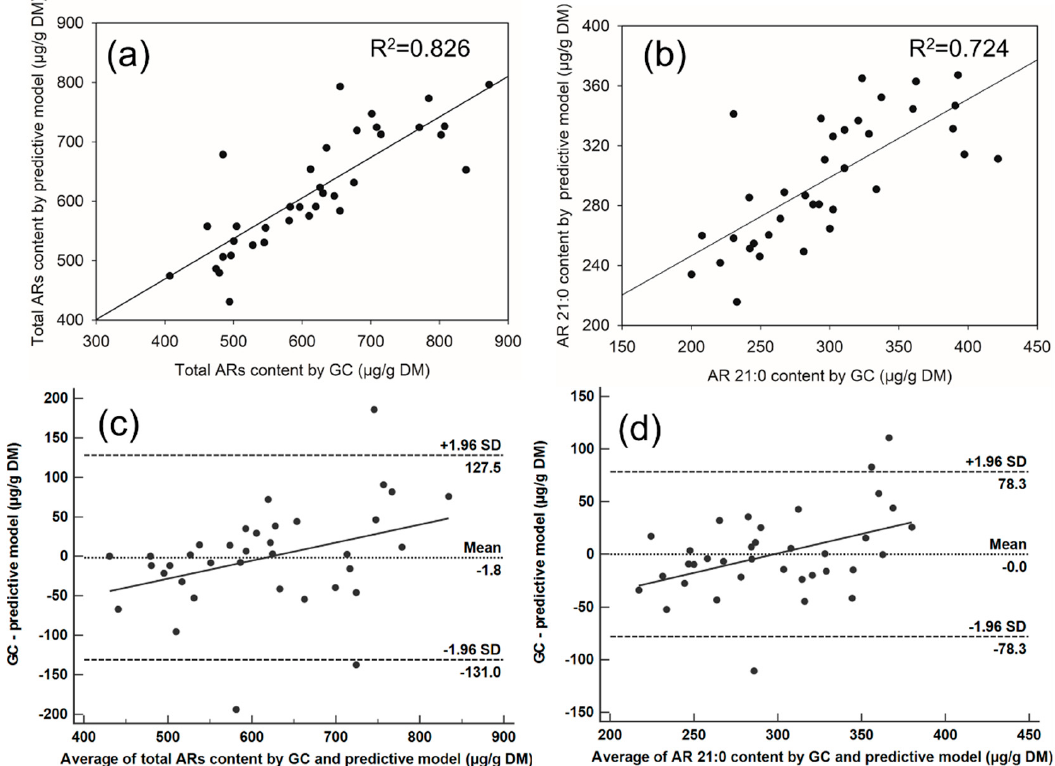
Figure 7. ( a ) AR 21:0 content in whole grain samples determined by GC and predictive model. y = 0.524x + 141.676 (n = 36, p < 0.001); ( b ) Total ARs content in whole grain samples determined by GC and predictive model. y = 0.683x + 195 (n = 36, p < 0.001). ( c ) and ( d ) The Bland–Altman plot illustrating the agreement between the predictive model-method and the GC-method. Average of the two methods is plotted on the x-axis and the observed difference between the methods on the y-axis (GC-predictive model), n =